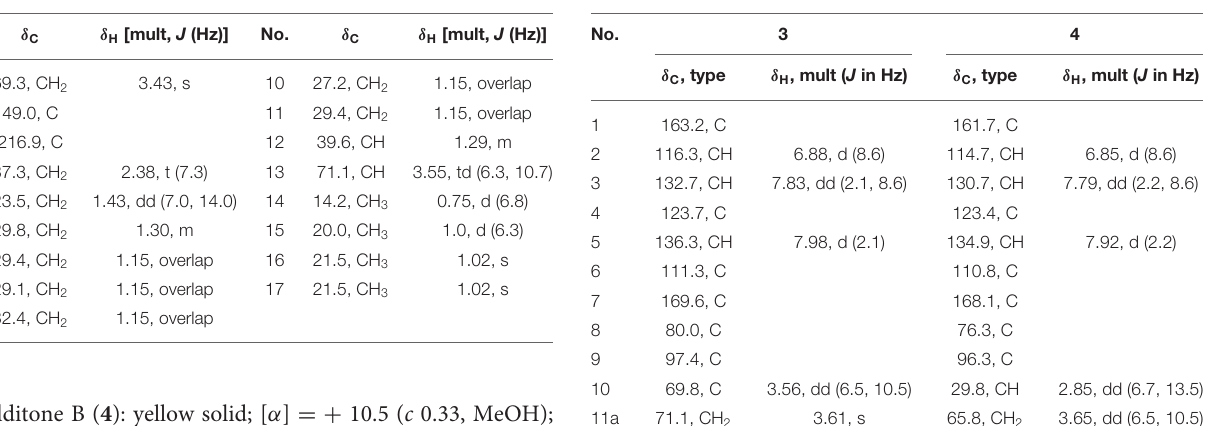
TABLE 1 | 1 H and 13 C NMR data of 2 in CDCl 3 . TABLE 2 | 1 H and 13 C NMR data of 3 and 4 in MeOH- d 4